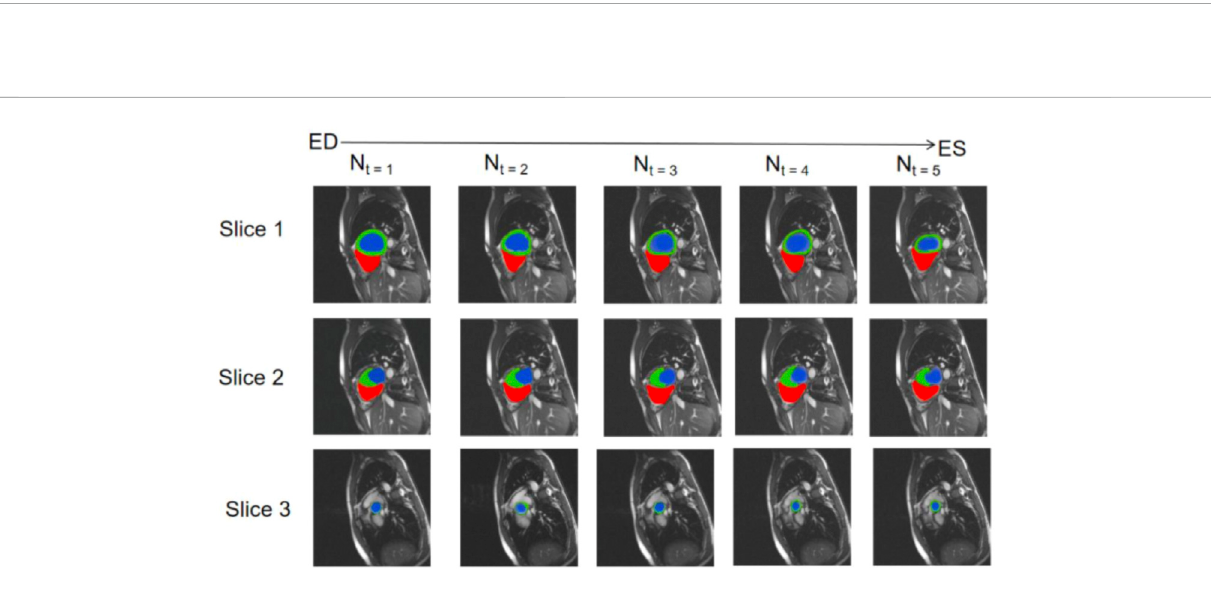
that the method showed more accurate segmentation results in the analysis of the data set representing the middle of the slice, but the segmentation of the base and the top of the slice was poor due to the top of the heart slice containing very few ventricular pixels, resulting in the ventricular boundary being too dif fi cult to con fi rm as ventricular density was close to tissue interference, etc.